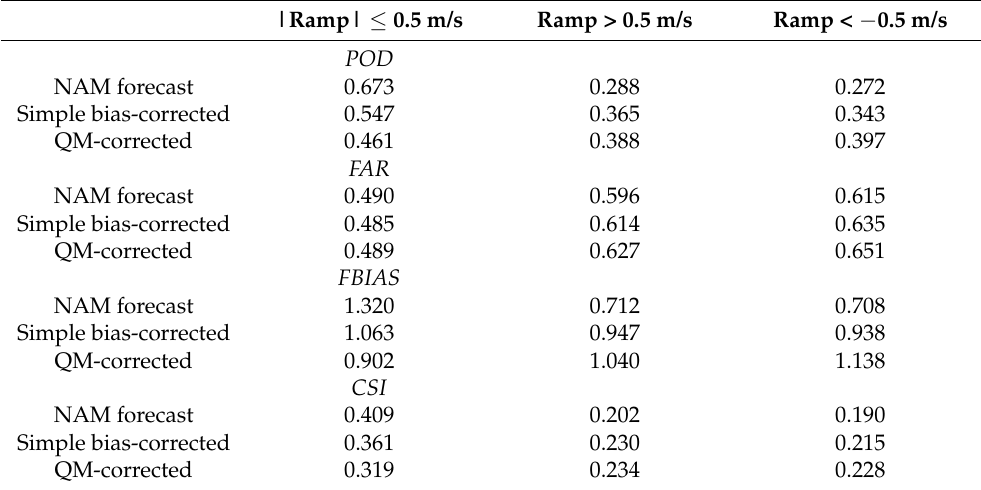
Table 2. Derived contingency table indexes wind NAM forecast (non-corrected), bias-corrected, and quantile mapping (QM)-corrected for